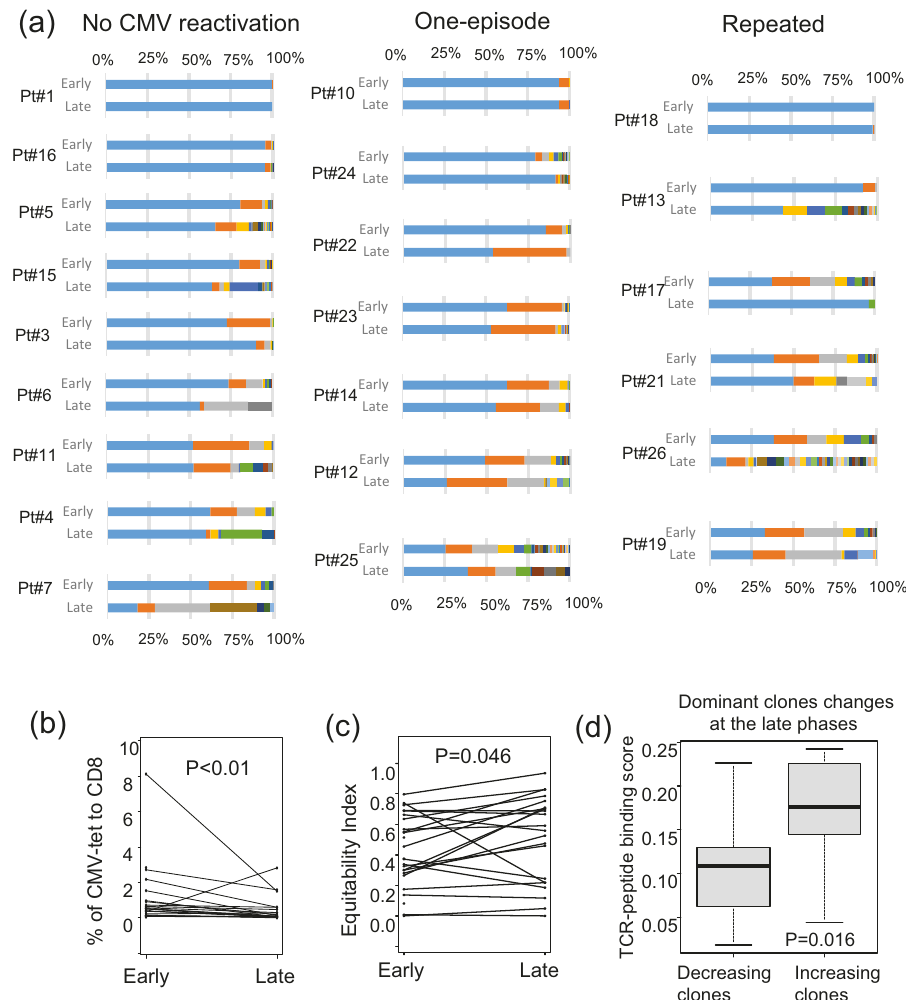
Fig. 3 Changes in proportions and diversity of all HLA-A24-restricted CMV-pp65-speci fi c cytotoxic T-cell (CMV-CTL) clones. a Changes in the proportions of individual CMV-CTL clones between the early and late phases after allo-HCT in each patient for whom samples were available at both points ( n = 22). The same colors suggest the same CMV-CTL clones between the phases within individual patients. b Changes in the proportions of CMV- CTLs in all groups pooled between the early and late phases of allo-HCT ( P < 0.001 by Wilcoxon ’ s signed-rank test). c Changes in Shannon ’ s equitability index of CMV-CTLs in all groups pooled between the early and late phases of allo-HCT ( P = 0.046 by Wilcoxon ’ s signed-rank test). d Difference in TCR- binding scores of the dominant CMV-CTLs, which accounted for >35% of all CMV-CTLs within individual recipients in the early or late phases after allo- HCT, between the decreasing and increasing clones at the late phases ( P = 0.016 by the Mann – Whitney test). Individual box and whisker plots were constructed by the 25th percentile (Q1), median, and 75th percentile (Q3) with whiskers of 1.5 times interquartile range (IQR)